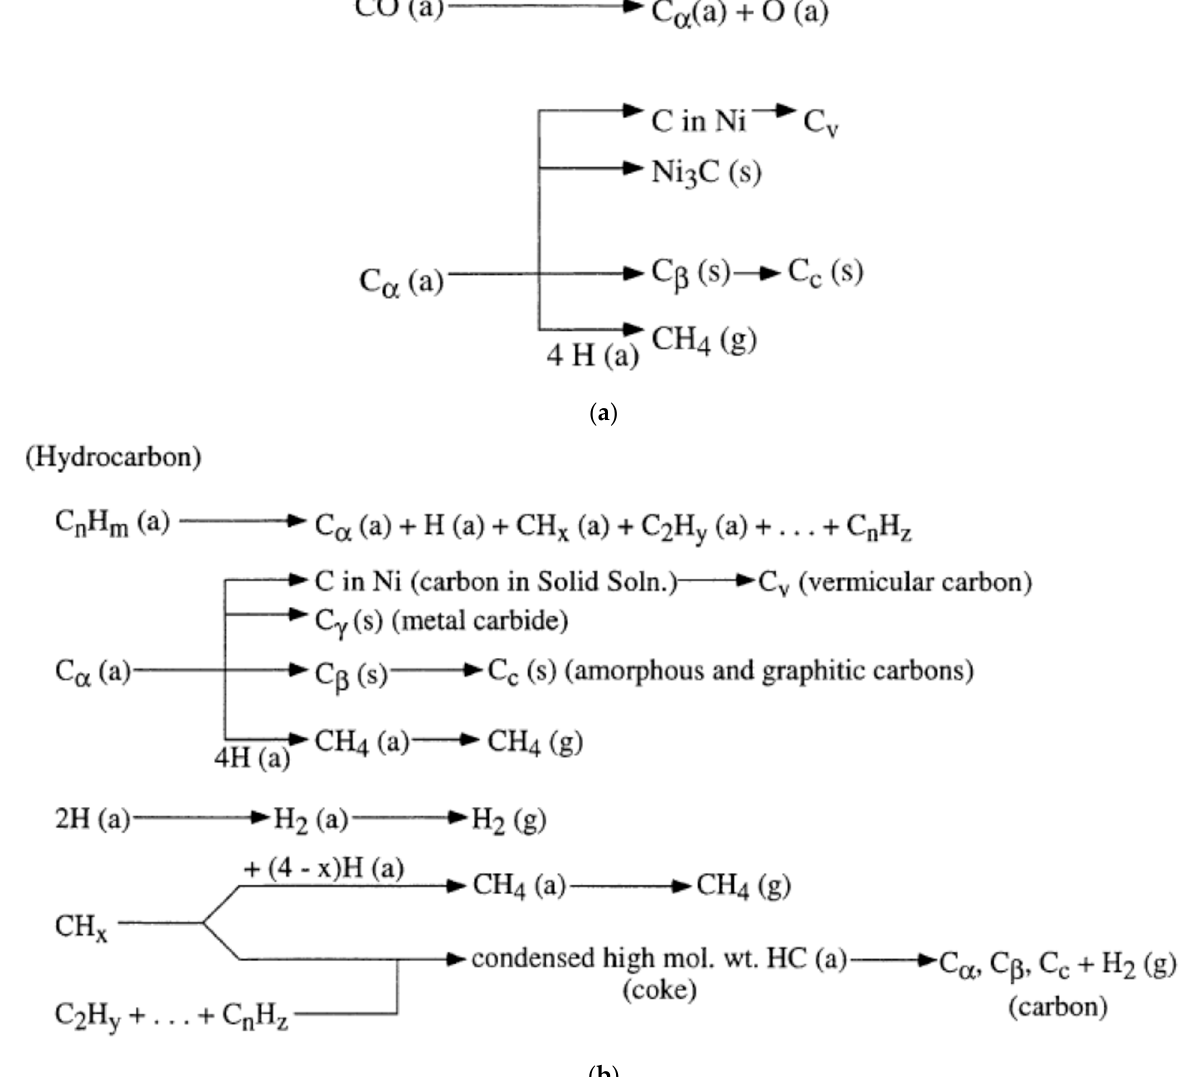
Figure 10. Coking mechanisms. ( a ) Formation, transformation, and gasification of carbon on nickel. ( b ) Formation and transformation of coke on metal surfaces (a, g and s refer to adsorbed, gaseous, and solid states, respectively). Reproduced with kind permission of Elsevier from [52].